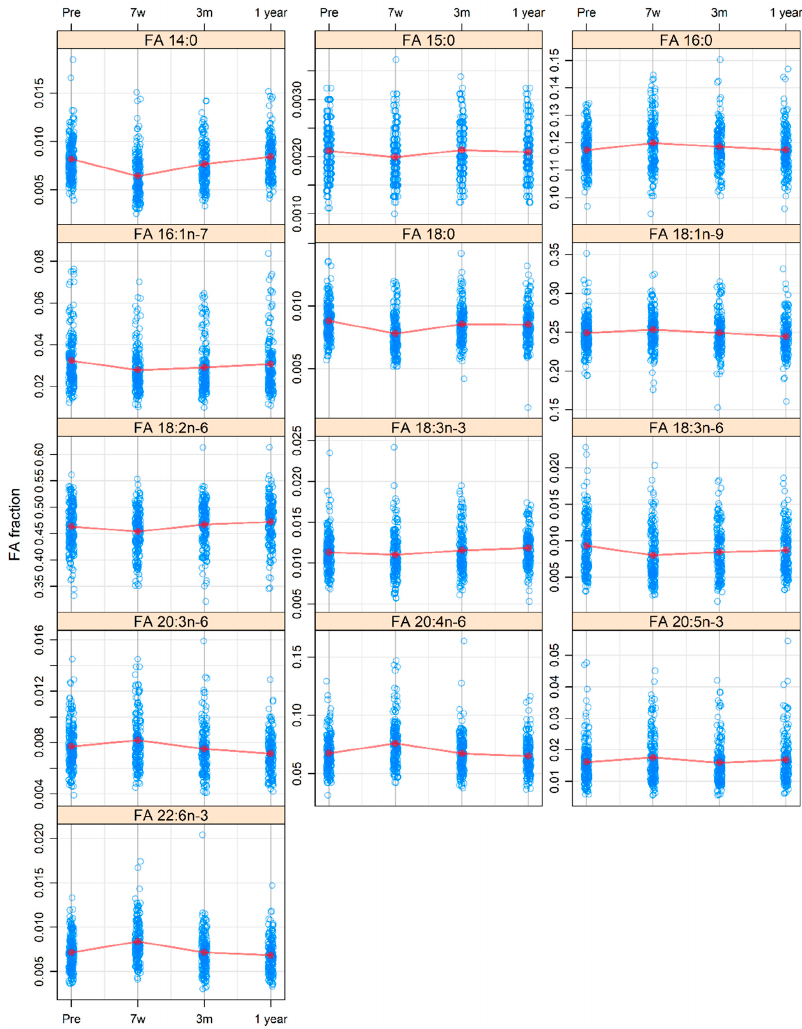
Figure 1. Serum levels of fatty acids (FAs) 14:0, 15:0, 16:0, 16:1n-7, 18:0, 18:1n-9, 18:2n-6, 18:3n-6, 18:3n-3, 20:3n-6, 20:4n-6, 20:5n-3, and 22:6n-3 at pre-treatment (pre), at 7 weeks after the start of treatment (7w), and at 3 months (3m) and 1 year (1 year) after the termination of treatment in patients with head and neck cancer. The values for the FAs are presented in relation to the total amount of FAs.